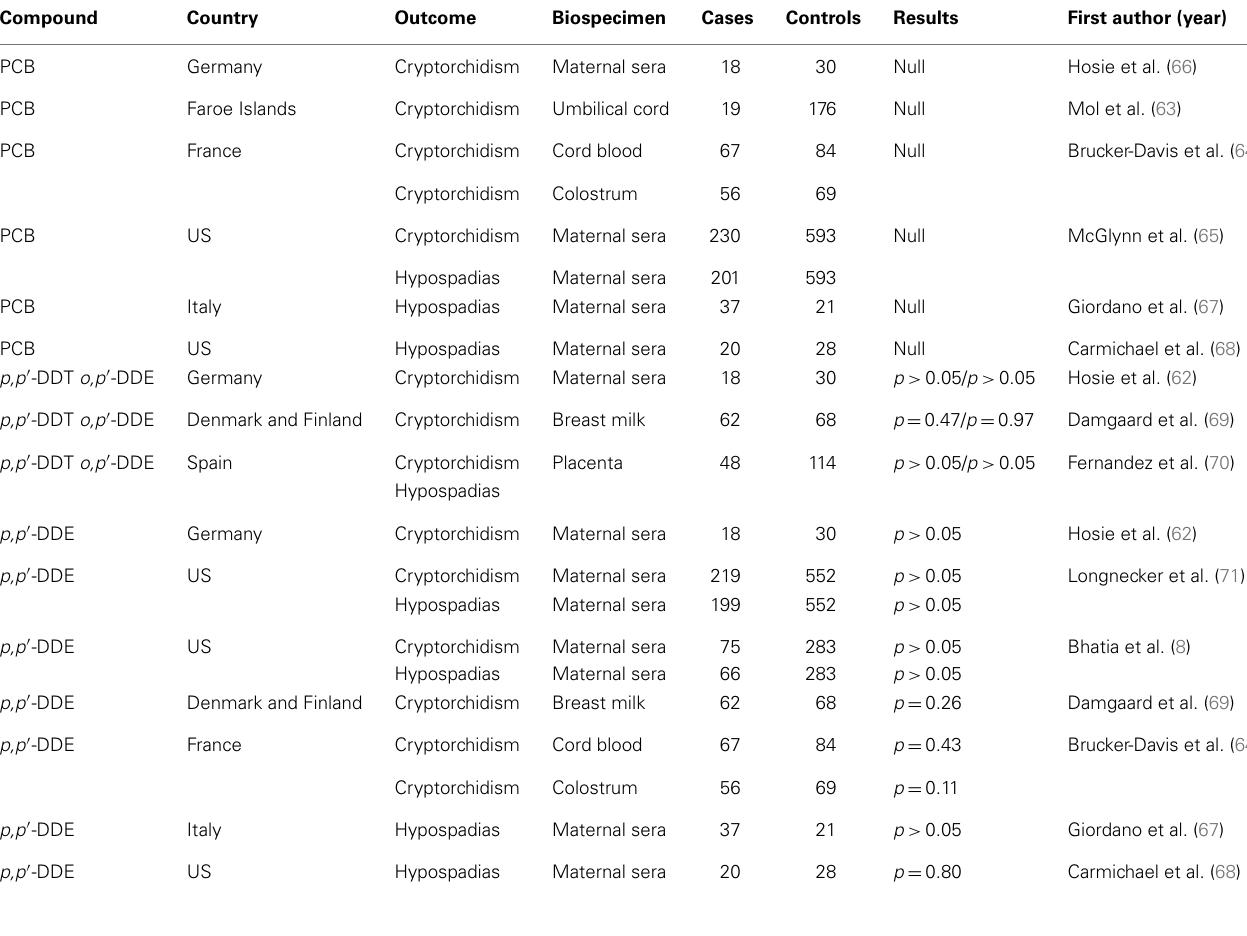
Table 3 | Case–control studies on relationships between cryptorchidism and hypospadias and endocrine disruptors including PCB and DDT/DDE .